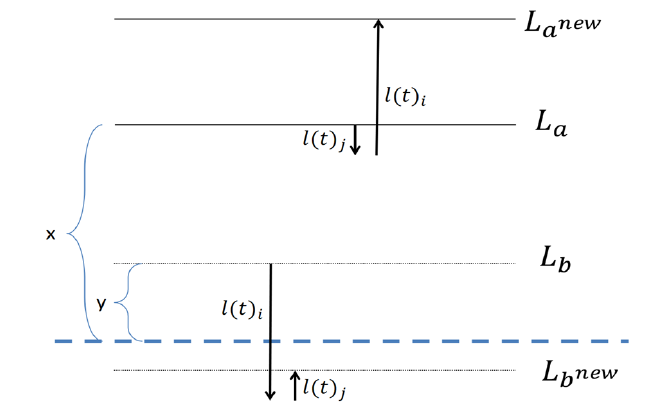
Figure 4. Clusters’ loads after replacement on different sides with reference to the